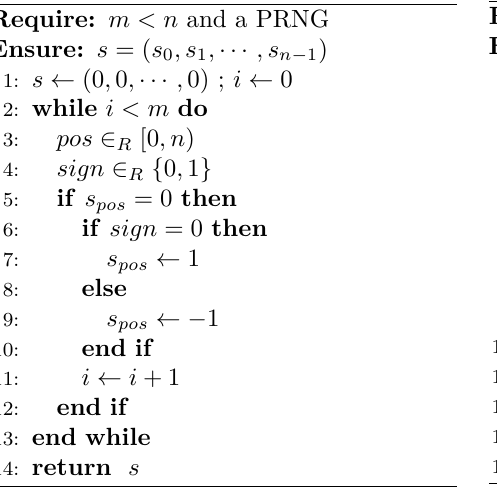
Algorithm 10 Trinary Sampling with m 0 +1’s and m 1 − 1’s